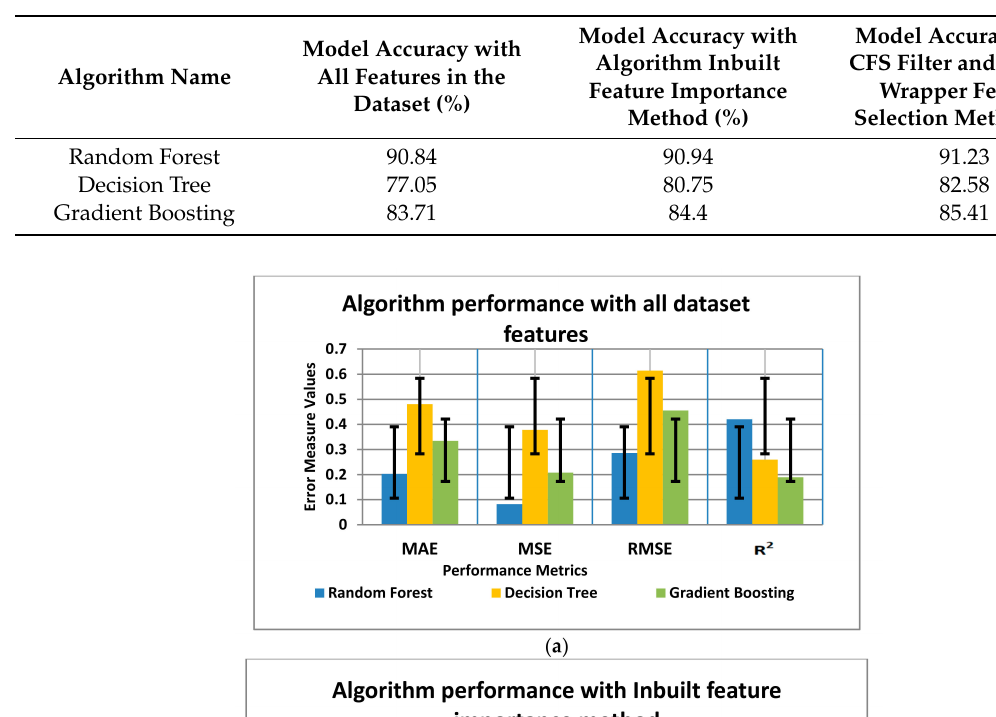
Table 6. Machine Learning Model Accuracy with the proposed hybrid feature selection algorithm.